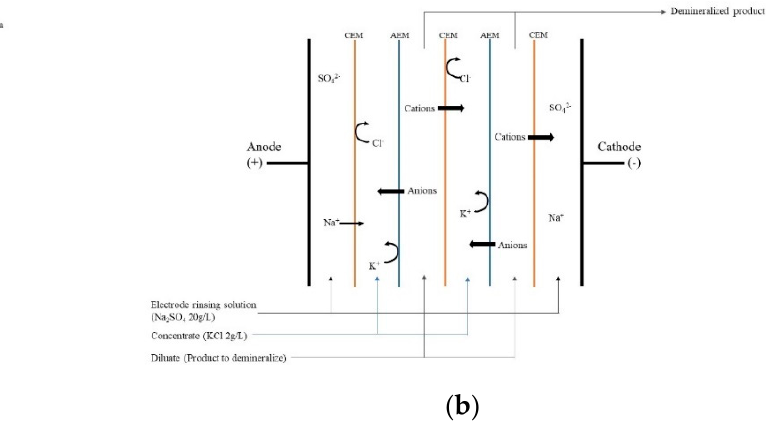
Figure 1. ( a ) Electrodialysis with ultrafiltration membrane cell configuration used to recover cationic peptides from whey protein concentrate hydrolysate; ( b ) electrodialysis cell configuration used to demineralize initial whey protein concentrate hydrolysate, peptide recovery fraction and final whey protein concentrate hydrolysate.